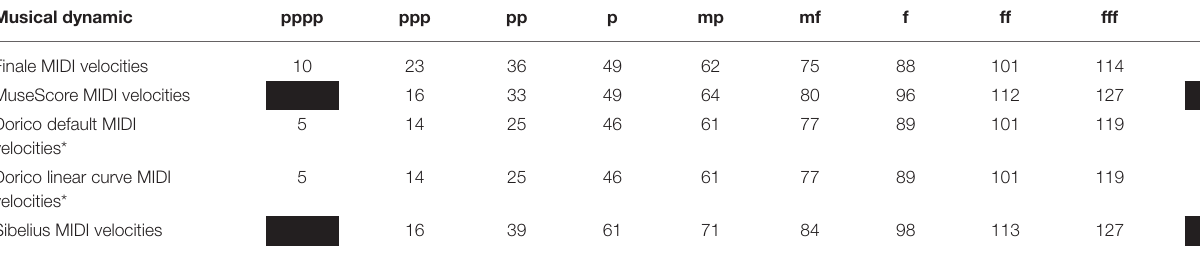
TABLE 1 | A comparison of dynamic markings and corresponding MIDI velocities used by various notation programs. Musical dynamic pppp ppp